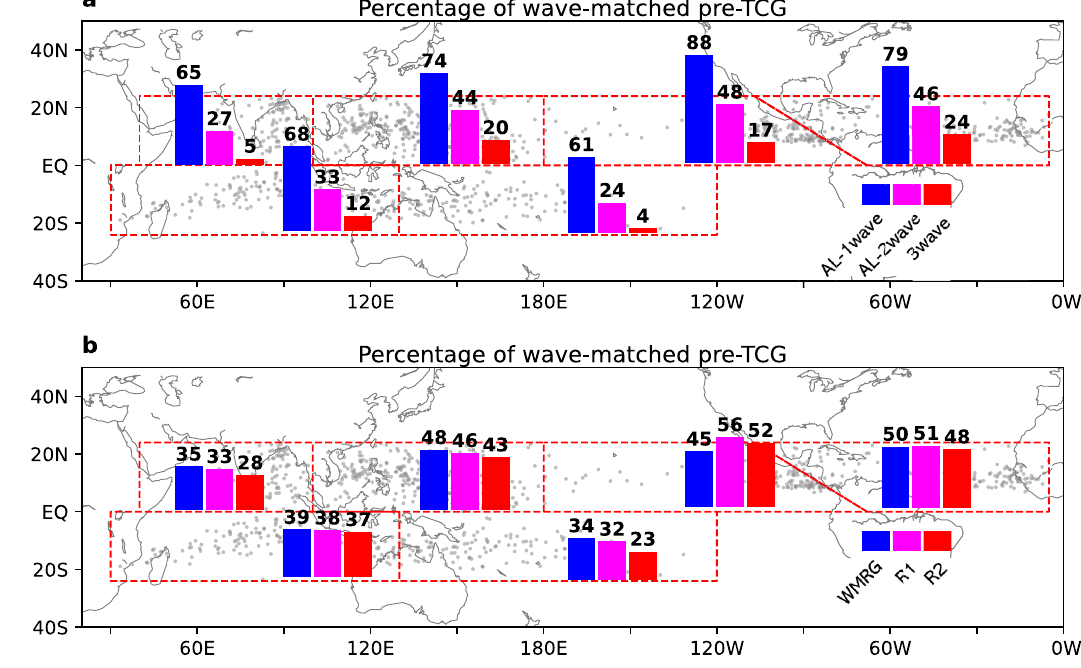
Fig. 1 | Percentages of pre-tropical cyclogenesis (pre-TCG) events matched in-phase to equatorial waves. a Percentages of pre-TCG events with strong vor- ticity matched in-phase to atleast one type (AL-1wave, blue bar),atleast two types (AL-2wave, magenta bar), and all three types of westward-moving waves (3wave, red bar), for each ocean basin, over 1980 – 2018. b as a , but for percentages of pre- TCG events with strong vorticity matched in-phase to each type of westward- moving waves: Westward-moving Mixed Rossby-Gravity wave (WMRG, blue bar),